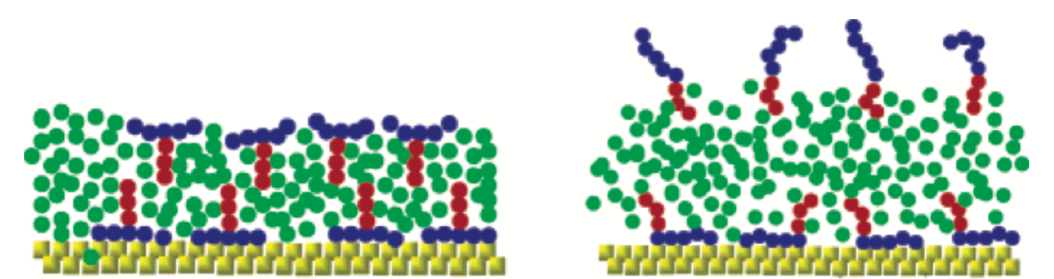
Figure 7. Results from a bead–spring CG model. Different scenarios of spreading depending on the molecular architecture of the surfactant. T-shaped surfactant versus flexible linear surfactant. Reprinted with permission from Ref. [68]. Copyright 2005 American Chemical